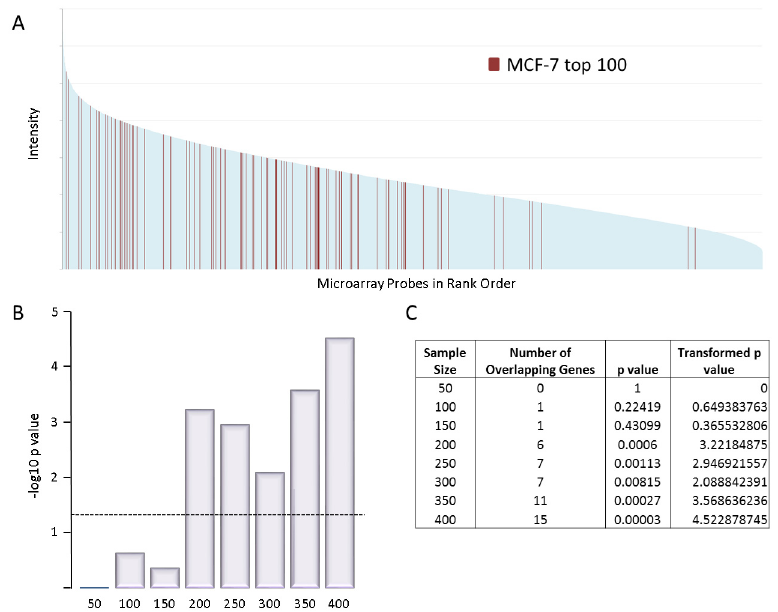
Fig 4. Integration preference with expression level. A: rank order plot showing intensity of all microarray probes for MCF-7. Shown in red are the top 100 gene clusters targetted by FeLV insertion. B: Transformed p values of the significance of association between the top insertion target genes and the most highly expressed genes for different sample sizes. The dashed line represents p = 0.05 significance level. C: Table showing the p values represented in B for the different sample